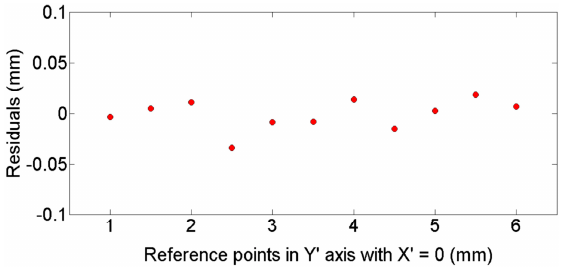
Figure 10. Residual of reference point positions along the Y’ axis with constant X’ = 0 [22].